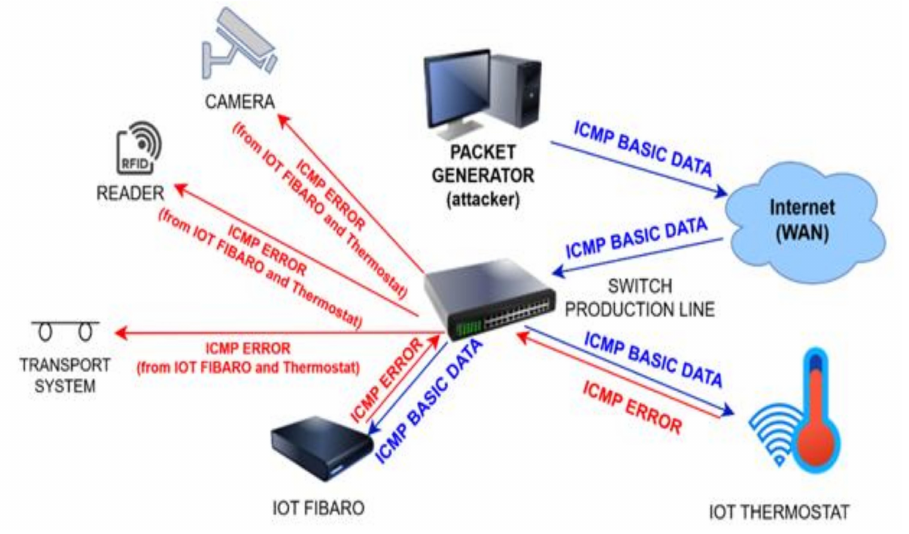
Figure 6. A visual illustration of the scenario 2 attack.